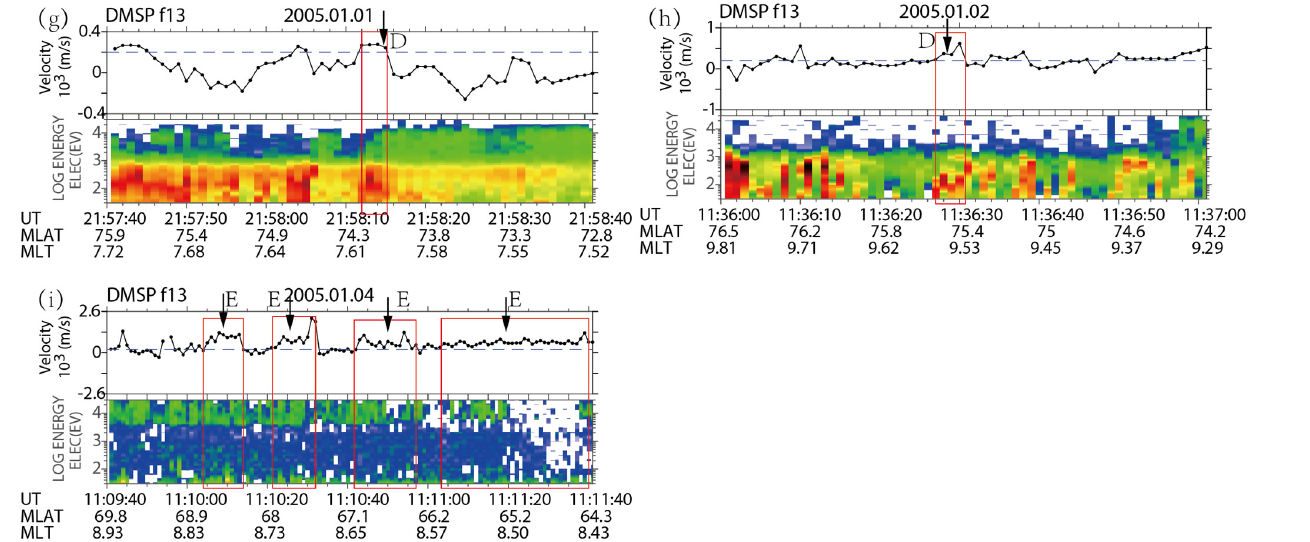
Figure 1. Corresponding relationship between the vertical ion drift velocity (top panel) and electron acceleration (bottom panel) for different types of ion upflows. The horizontal blue dashed line is the threshold value of 200 m/s. The red box indicates the interval of typical ion upflows, and the black arrow and the letters (A–E) next to it indicate the type of ion upflows. ( a , b ) Type A ion upflows, ( c , d ) type B ion upflows, ( e , f ) type C ion upflows, ( g , h ) type D ion upflows, ( i ) type E ion upflows.